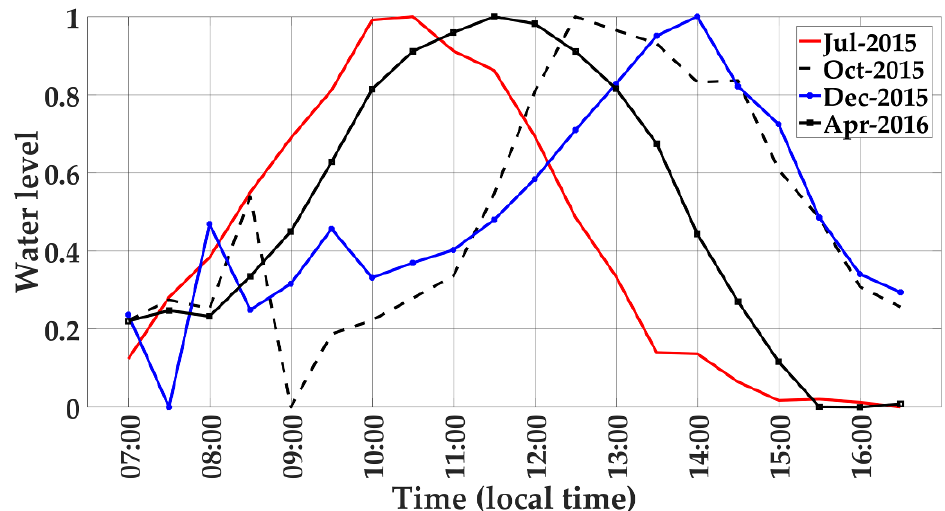
Figure 5. Normalized water level estimates for the diurnal tidal cycles for 4 seasonal periods, as determined from phenocam-2, ROI 3.